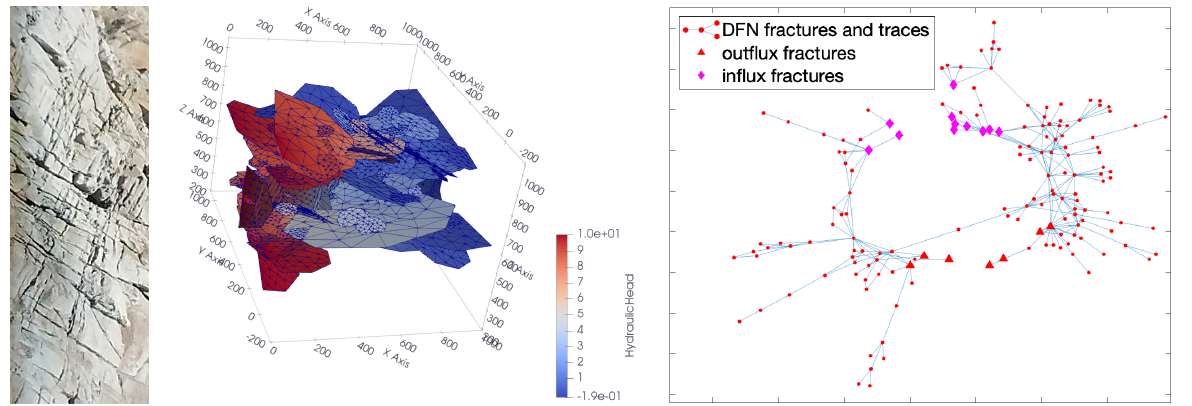
Figure 11. External surface of a natural fractured medium ( left ), a 3D view of a DFN ( center ), and a graph representation of the same DFN ( right ). The DFN illustrated in this figure is DFN158, i.e., the one used for the numerical tests of Section